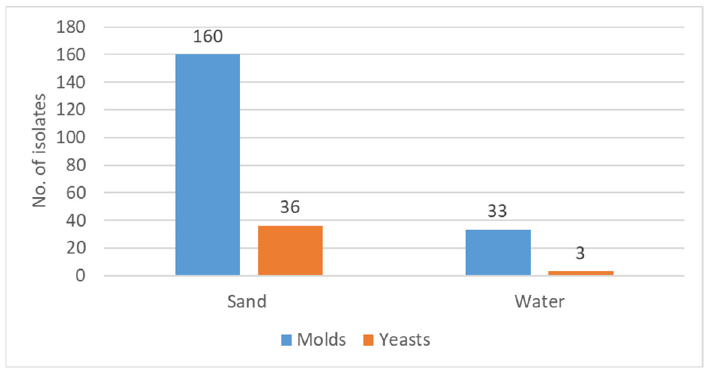
Figure 1. Total number of fungal isolates in sand and in water. The Y-axis represents the number of isolates of yeasts and molds in each medium.